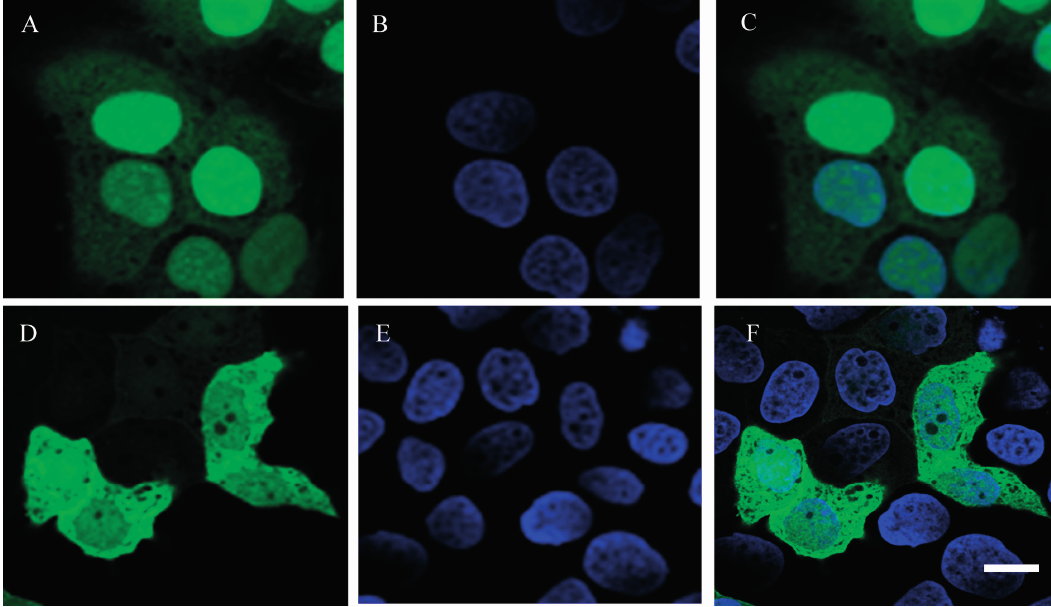
Figure 4. Localization of EGFP and YieF-EGFP fusion protein in transient transfectants. Green fluorescence indicated the localization of empty fluorescent vector EGFP ( A ) and fusion protein YieF-EGFP ( D ). Nuclei were counterstained with Hoechst 33258 ( B , E ). C is the overlay of A and B , and F is the overlay of D and E . Scale Bar = 10 μ